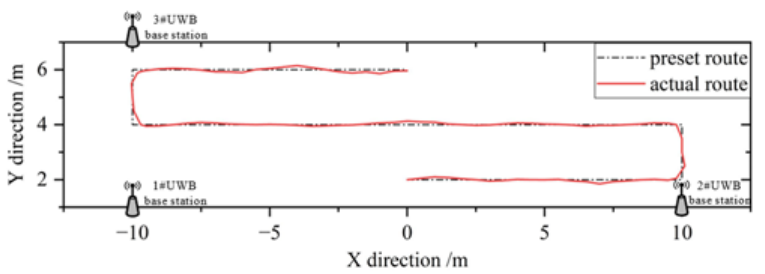
Figure 10. Comparison of the preset route and actual